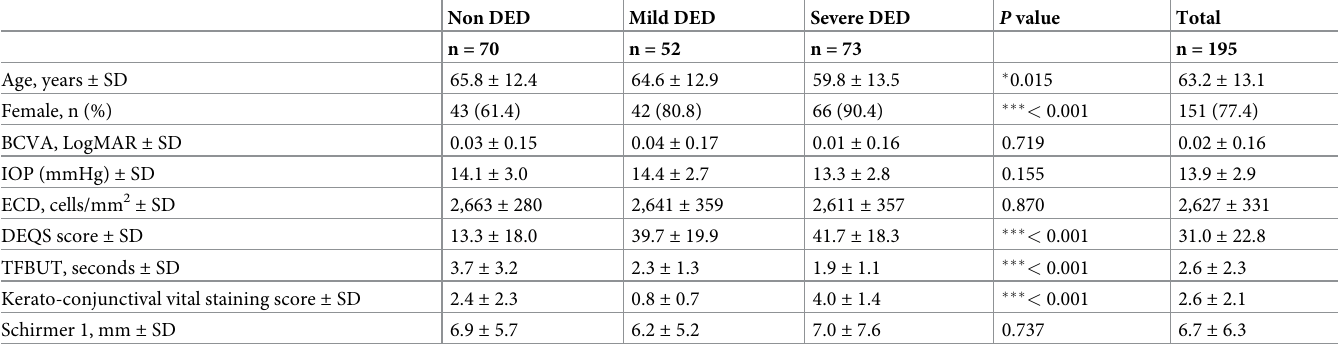
Table 1. Characteristics of study